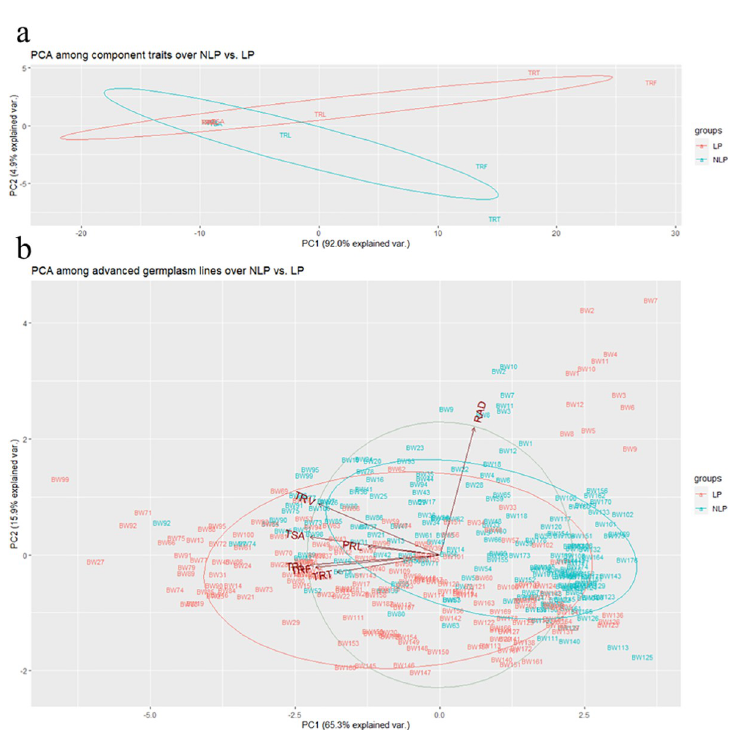
Fig 3. Principal component analysis. PCA for seven root architectural traits (a), PCA for genotypes under two P regimes. Green circle represents NLP and orange represents LP conditions (b). Proportion of variances for PC1 and PC2 are shown in